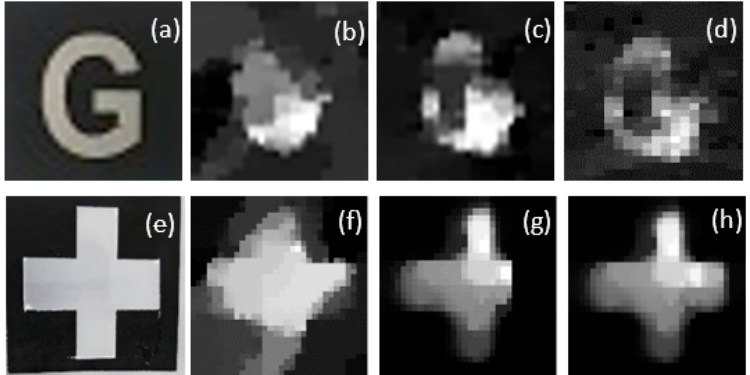
Figure 9. Images of different compression ratios reconstructed: ( a ) an original target image with pixel size 32 × 32; ( b – d ) reconstructed images using different numbers of random speckle patterns (M takes the values 100, 200, and 300, respectively, and different compression ratios from 9.76% and 19.53% to 29.29%); ( e ) an original target image with pixel size 32 × 32; and ( f – h ) reconstructed images using different numbers of random speckle patterns.